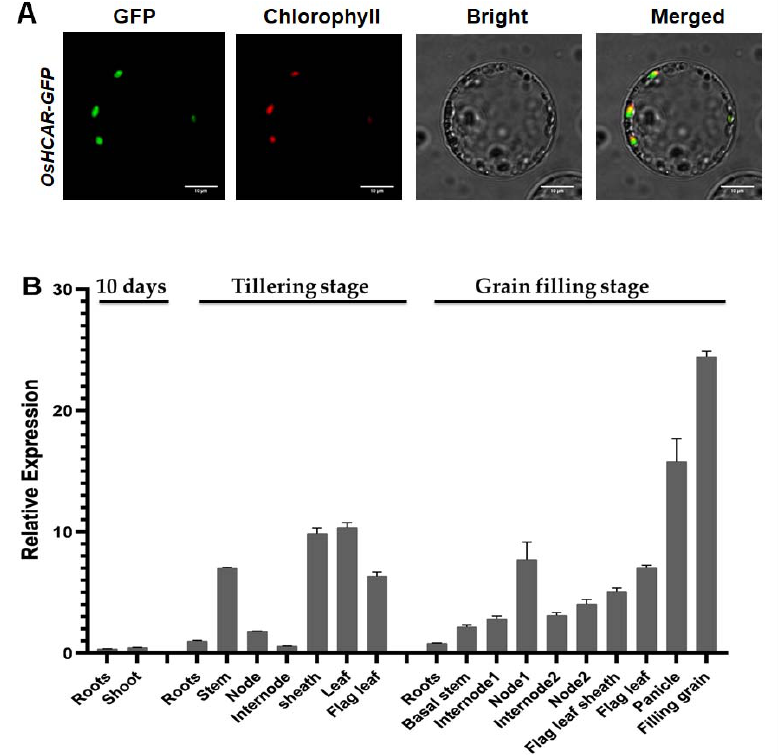
Figure 7. qRT-PCR analysis of wild-type OsHCAR messenger RNA expression and subcellular localization of OsHCAR . ( A ) Subcellular localization of OsHCAR-GFP in rice protoplasts. Bar = 10 µ m ( B ) Quantitative relative expression levels of OsHCAR in various tissues of IR64 at different growth stages. Rice ubiquitin gene ( LOC_Os03g13170 ) was used as reference gene.